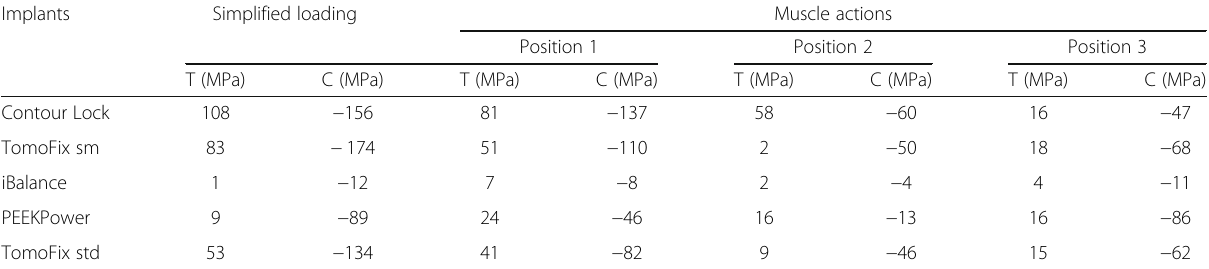
Table 5 Tensile (T) and compressive (C) stresses in the cross sections of maximum von-Mises stress in the implants Implants Simplified